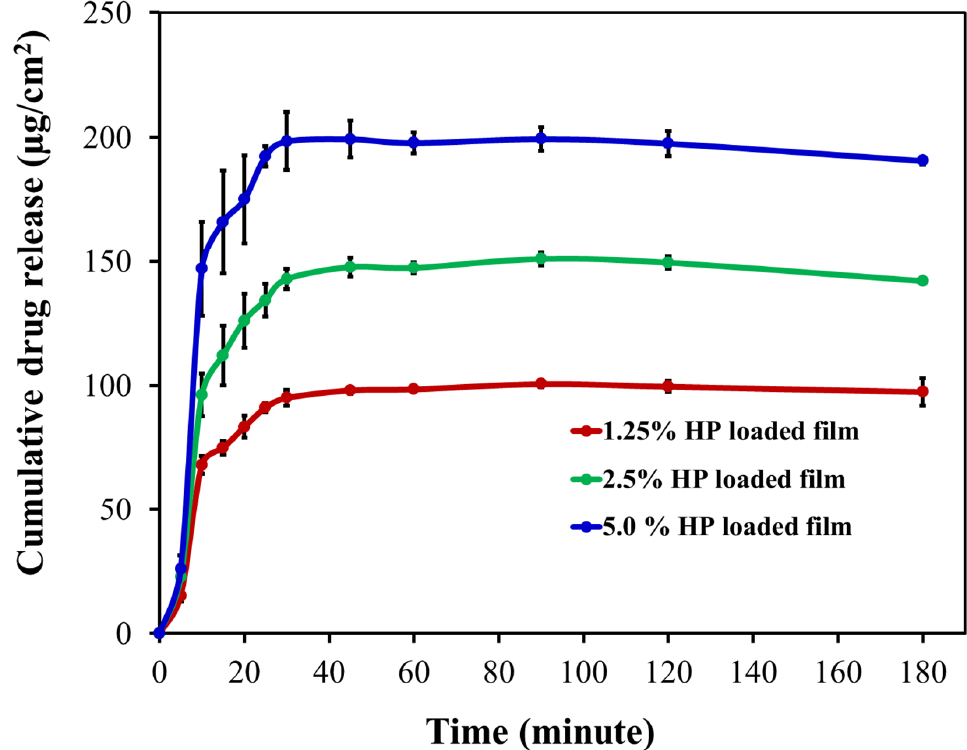
Figure 13. Cumulative drug release per unit area of CHI/P3HPEI films loaded with haloperidol (HP) at various % drug loading (5.0, 2.5 and 1.25%).